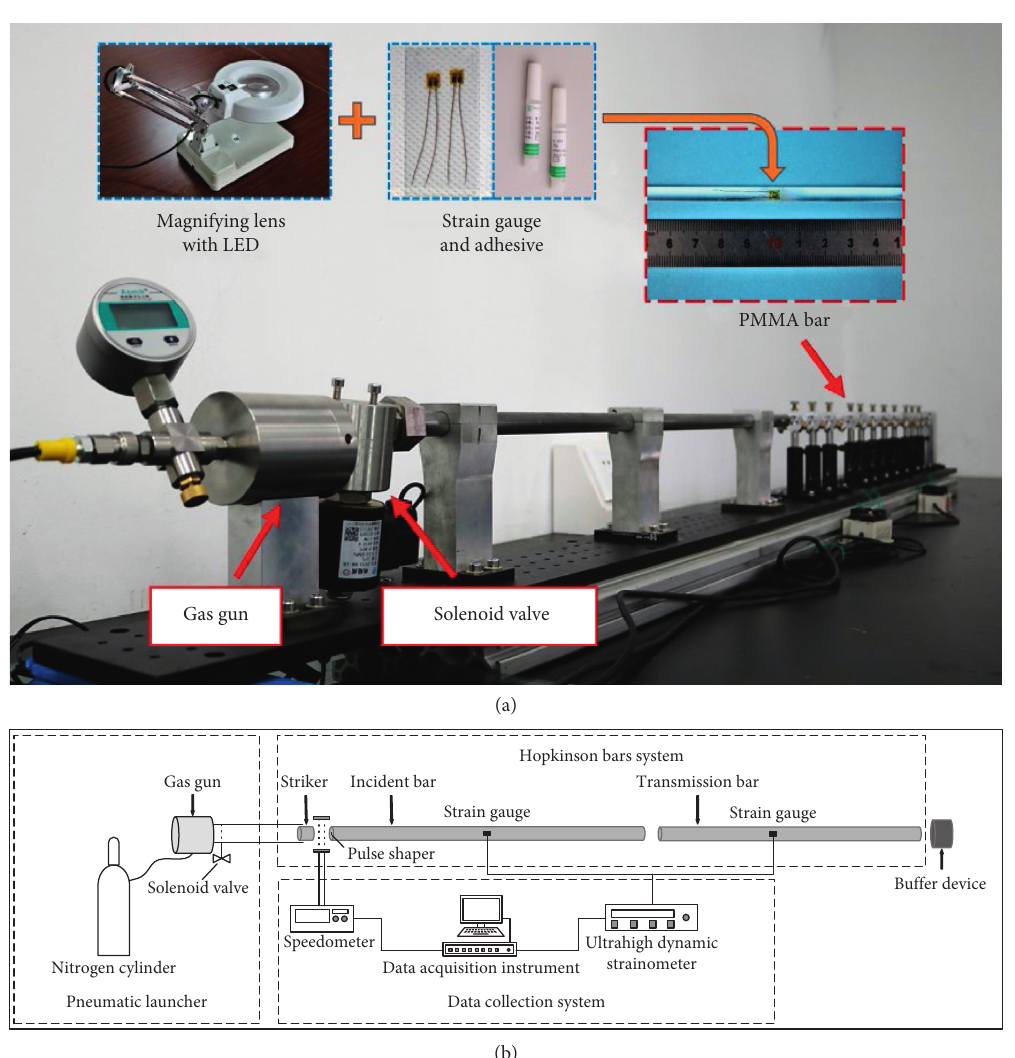
Figure 2: V 6mm SHPB experimental system. (a) Actual diagram. (b) Schematic